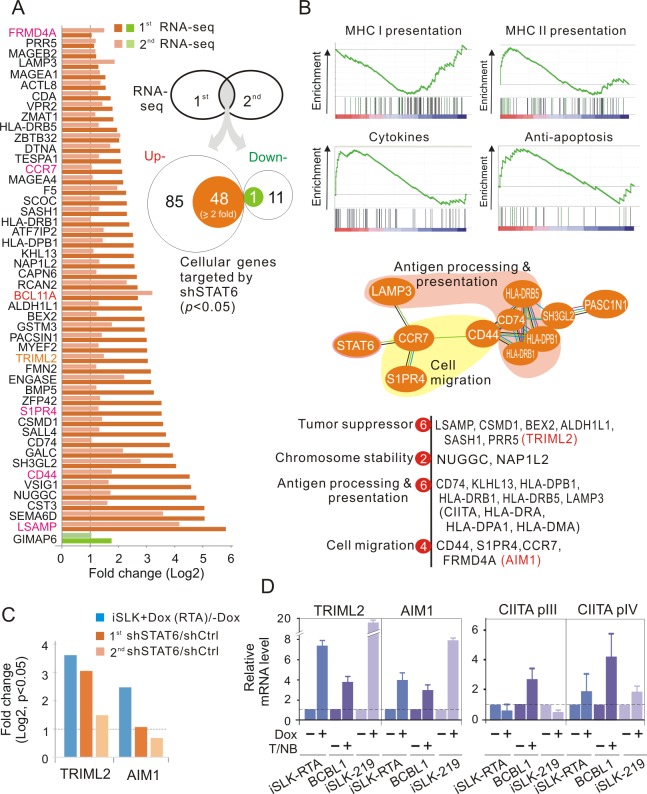
STAT6 knockdown significantly turns over cellular gene expression of PEL cells.(A) The expression of 49 cellular genes was significantly affected by STAT6 knockdown in PEL cells. BC3 and BCBL1 cells with or without STAT6 knockdown (S6 Fig) were individually subjected to RNA deep-sequencing analysis. The cellular genes with significantly change in the presence of STAT6 knockdown are shown. (B) Reduction of STAT6 led to the increased gene expression of MHC II-, cytokine- or anti-apoptosis-related proteins in PEL cells. The molecules related to antigen processing and presentation, cell migration, tumor suppressor, and chromosome stability are highlighted. (C) Expression of TRIML2 and AIM1 was consistently enhanced by RTA or STAT6 knockdown. The results were the RNA deep-sequencing analysis of iSLK cells with Doxycycline-inducible RTA (S5 Fig) and PEL cells with STAT6 knockdown. (D) Quantitative PCR analysis of TRIML2, AIM1 and CIITA expression in the iSLK-RTA and iSLK-219 cells treated with Doxycycline, or BCBL1 cells treated with TPA and sodium butyrate (T/NB) for 24 h.